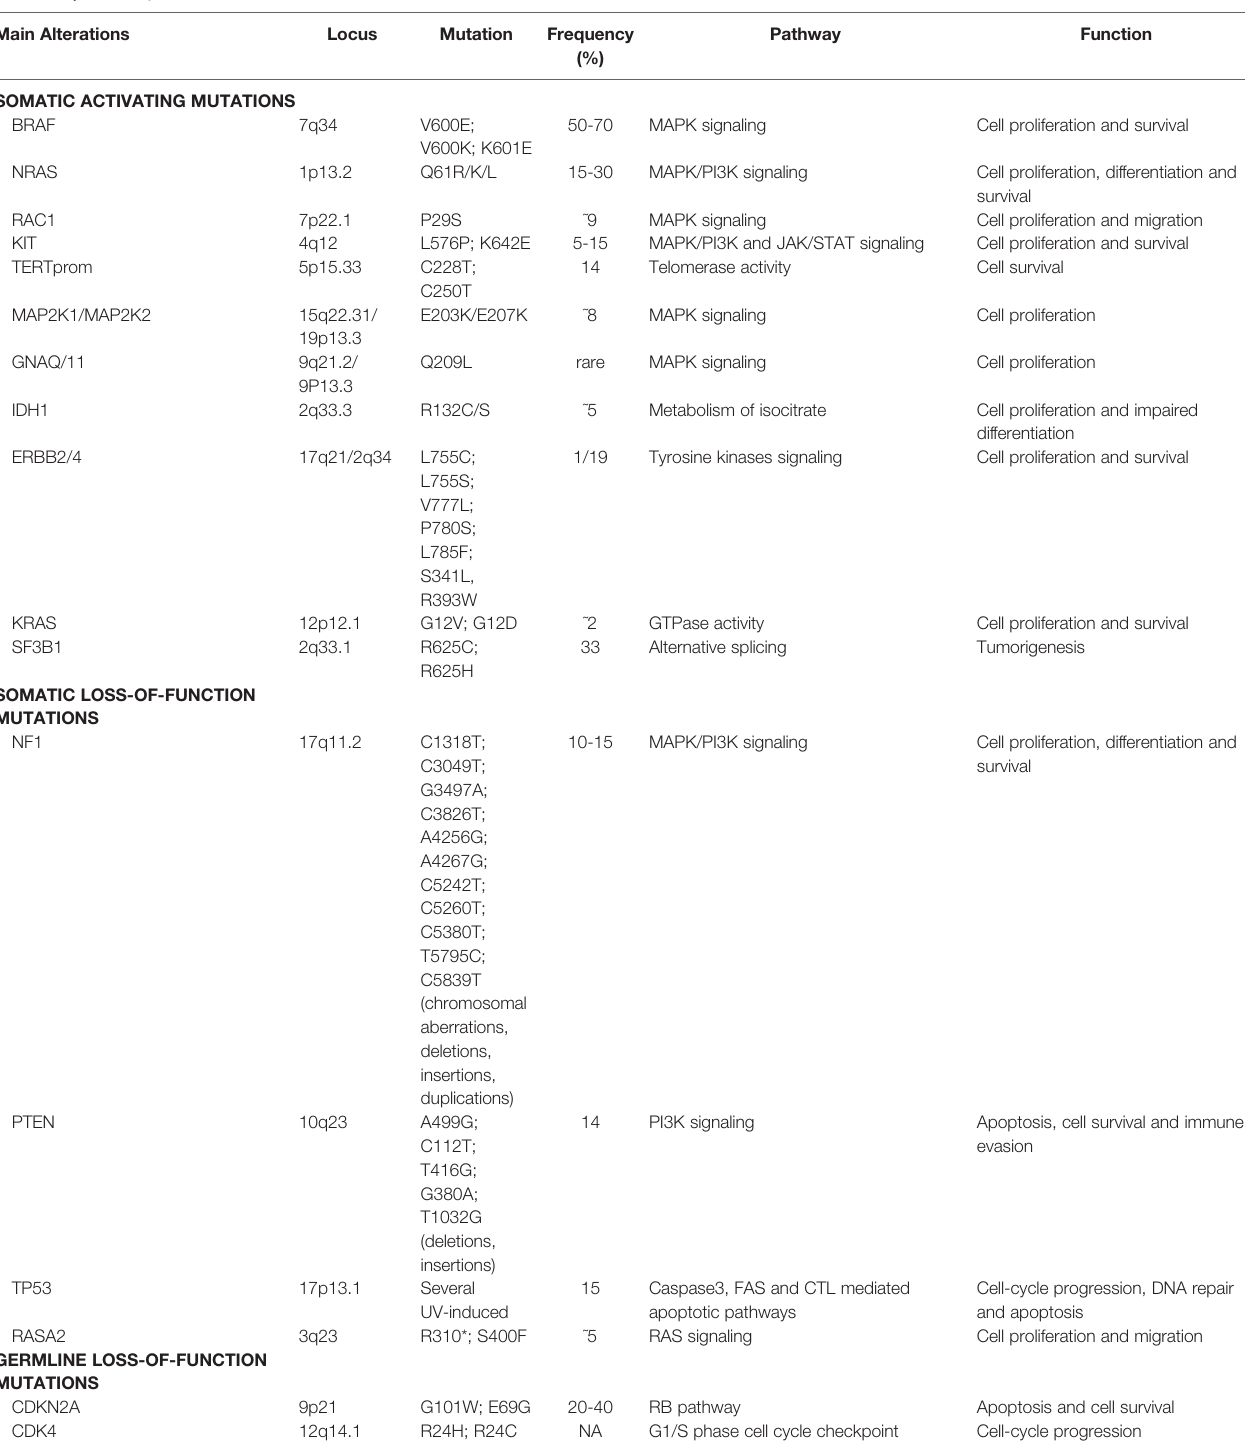
TABLE 1 | Summary of the main molecular alterations in cutaneous melanoma described in this